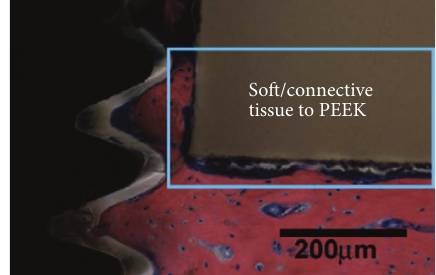
Figure 1: PEEK bioinert properties and growth of soft tissue around it